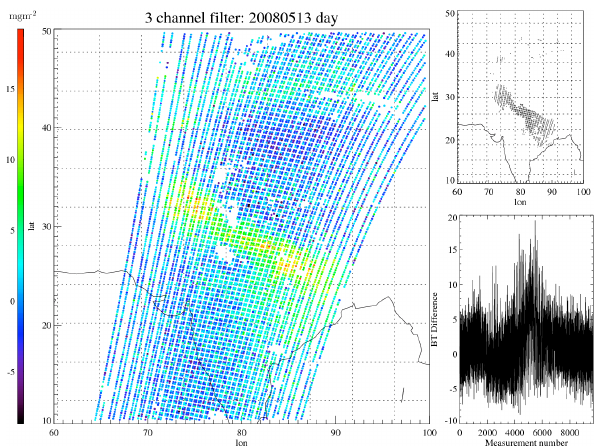
Fig. 10. Ammonia detected across Asia for the morning overpass on 13 May 2008 using the existing three channel filter with esti- mated total column amounts given in mgm − 2 . A map of positive detections in the 99% confidence interval is shown in the top-right panel of each figure. The distribution of detected ammonia for each measurement is shown in the bottom-right panel of each figure.